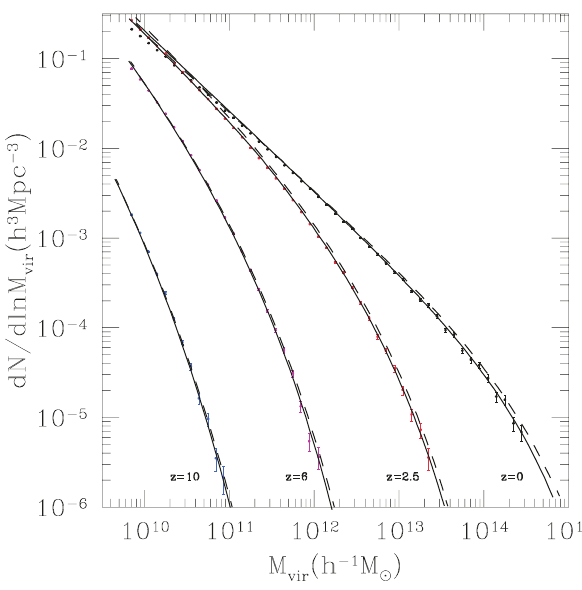
Figure 3. Same as in Figure 2 but for Tinker’s MF.